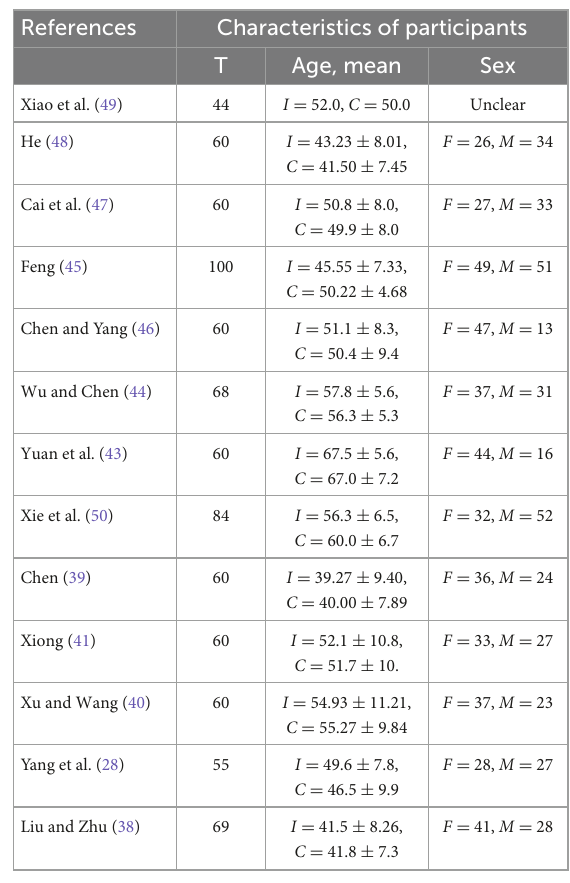
TABLE 1 Baseline features of the included studies